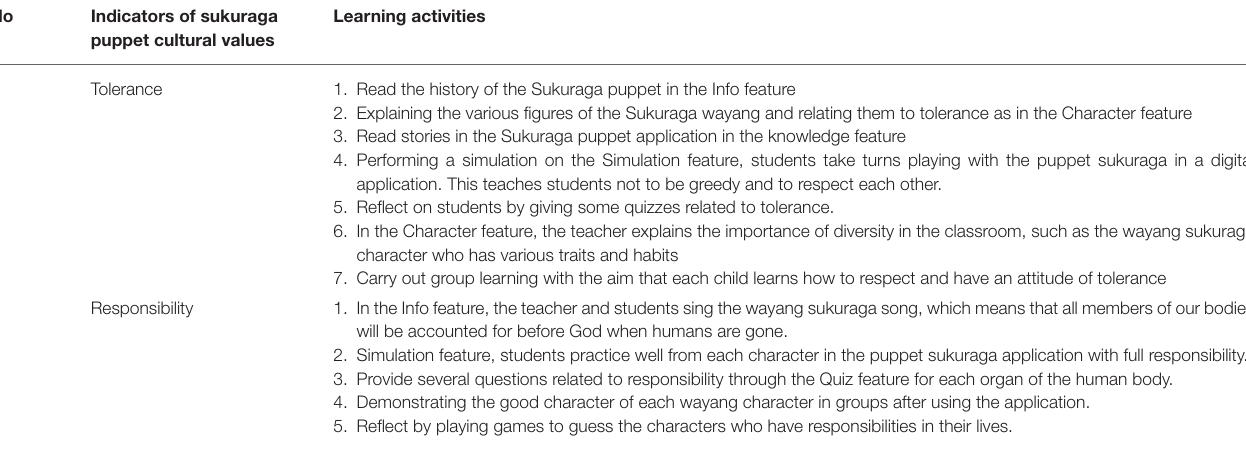
TABLE 5 | Indicators and learning